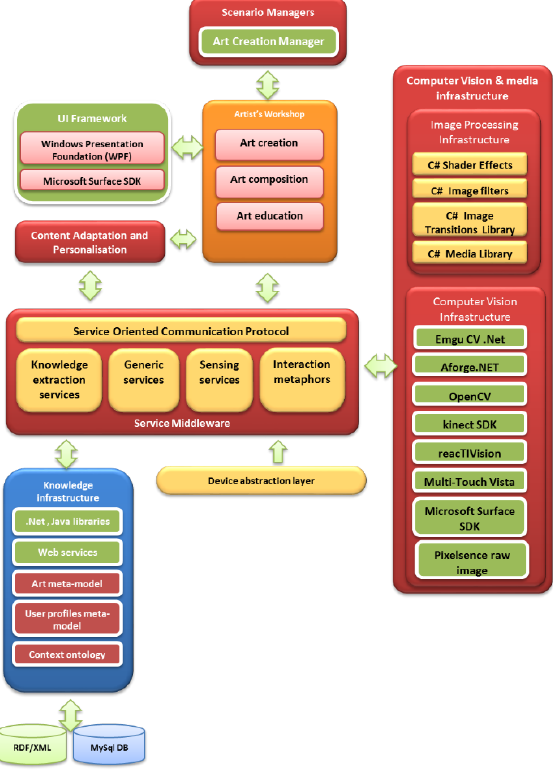
Figure 2. Abstract service oriented